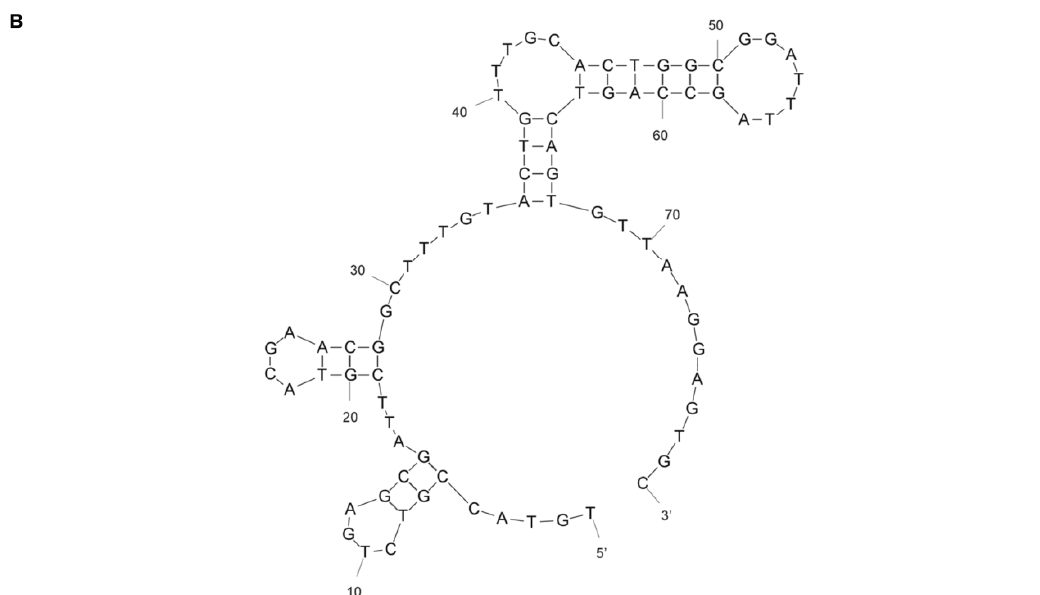
Figure 3. Sequence and structure of R12.23 ssDNA MRE. ( A ) ssDNA sequence of atrazine MRE R12.23; ( B ) Predicted R12.23 secondary structure by Mfold